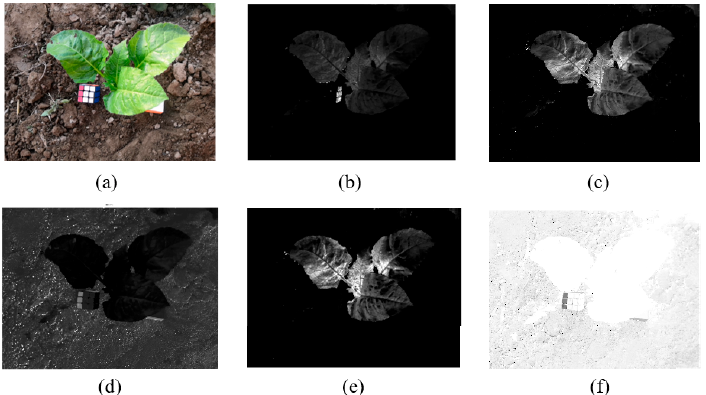
Figure 2. Images using different indices: ( a ) original image; ( b ) NDI image; ( c ) ExG image; ( d ) ExR image; ( e ) ExGR image; ( f ) VEG image.